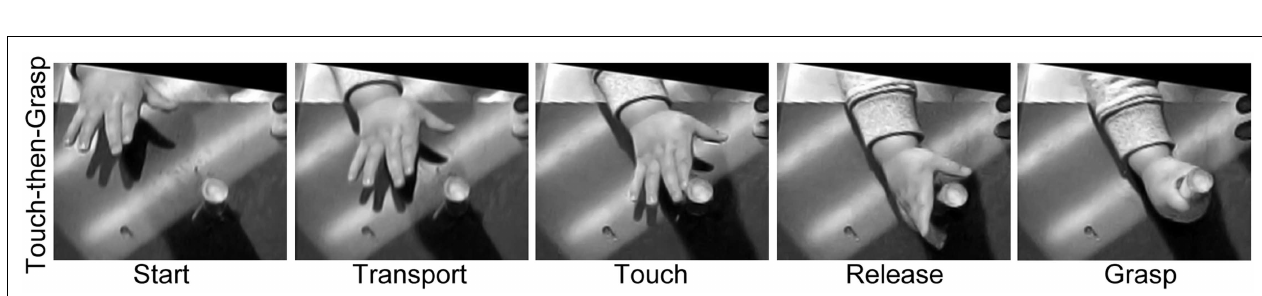
FIGURE 3 | Representative still frames illustrating theTouch-then-Grasp strategy used by a macaque monkey to acquire a visible target 5months after a bilateral corticospinal tract lesion . Note: even though vision is